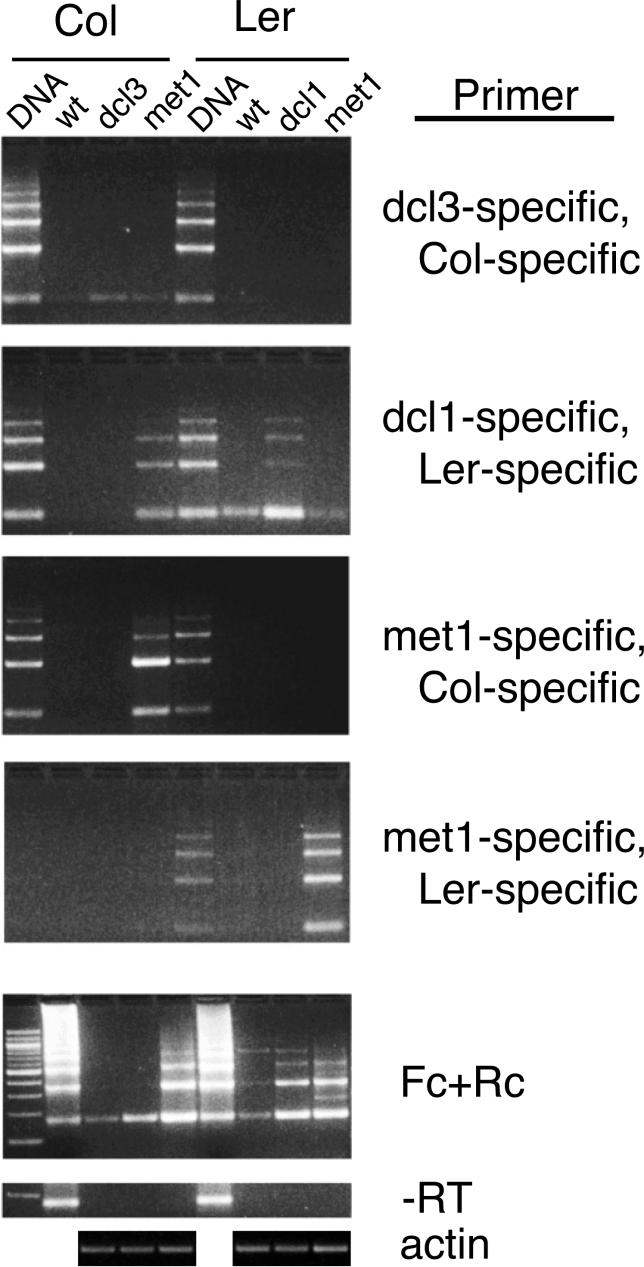
Polymorphic Regulation of cen180 TranscriptsPrimers were designed to recognize sample cen180 cDNAs from dcl1 and met1 mutants of Landsberg erecta (see Figure 3C) and dcl3 and met1 mutants of Columbia. PCR amplification using genomic DNA templates (DNA) tested for the presence of the particular repeats in the genome of each ecotype. RT-PCRs using RNA detected transcripts in WT (wt) and mutants of each ecotype as indicated. The cen180 Fc + Rc primers served as positive controls in the presence of reverse transcriptase and negative controls in its absence. RNA was prepared from aerial tissues from 28-day-old plants.